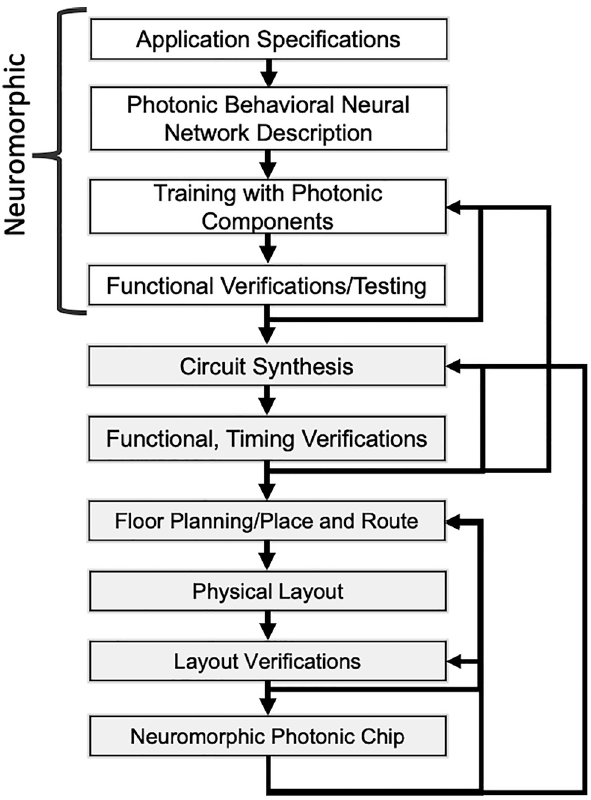
Figure 2: Envisioned design flow for neuromorphic photonics system design. At the top of the design flow stack, neuromorphic- specific steps account for accurate translation of application statement into trained set of